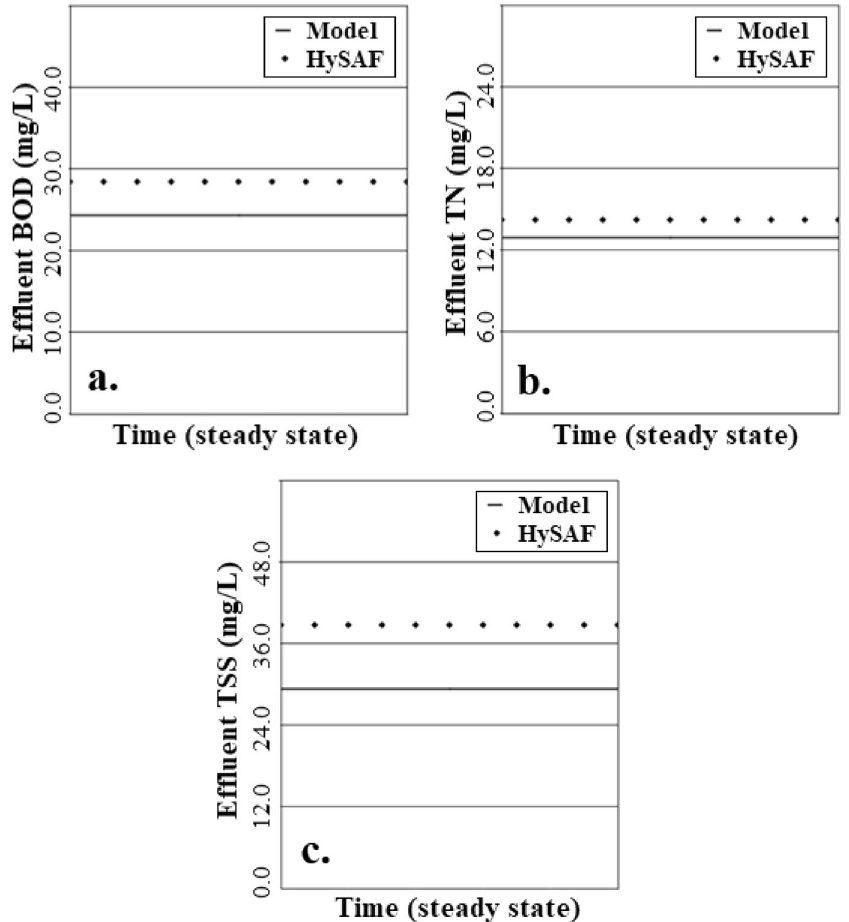
Figure 7. Achieved accuracy of the parameter estimation phase for ( a ) BOD model, ( b ) TN model, and ( c ) TSS model.